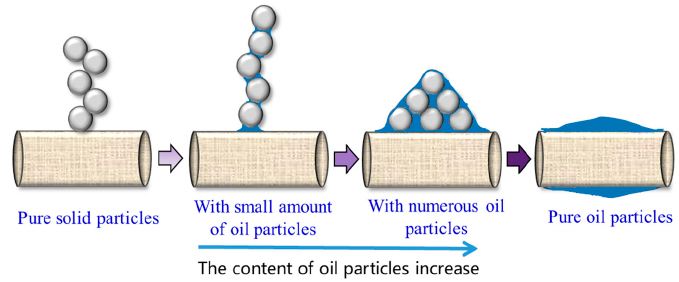
Figure 10. The evolution of particle deposition behavior over oil content.